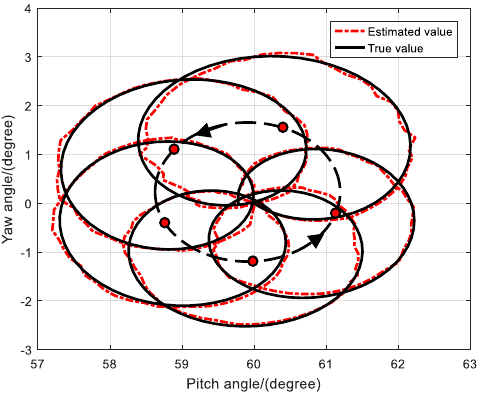
Figure 8. Oscillation trajectory of the projectile.